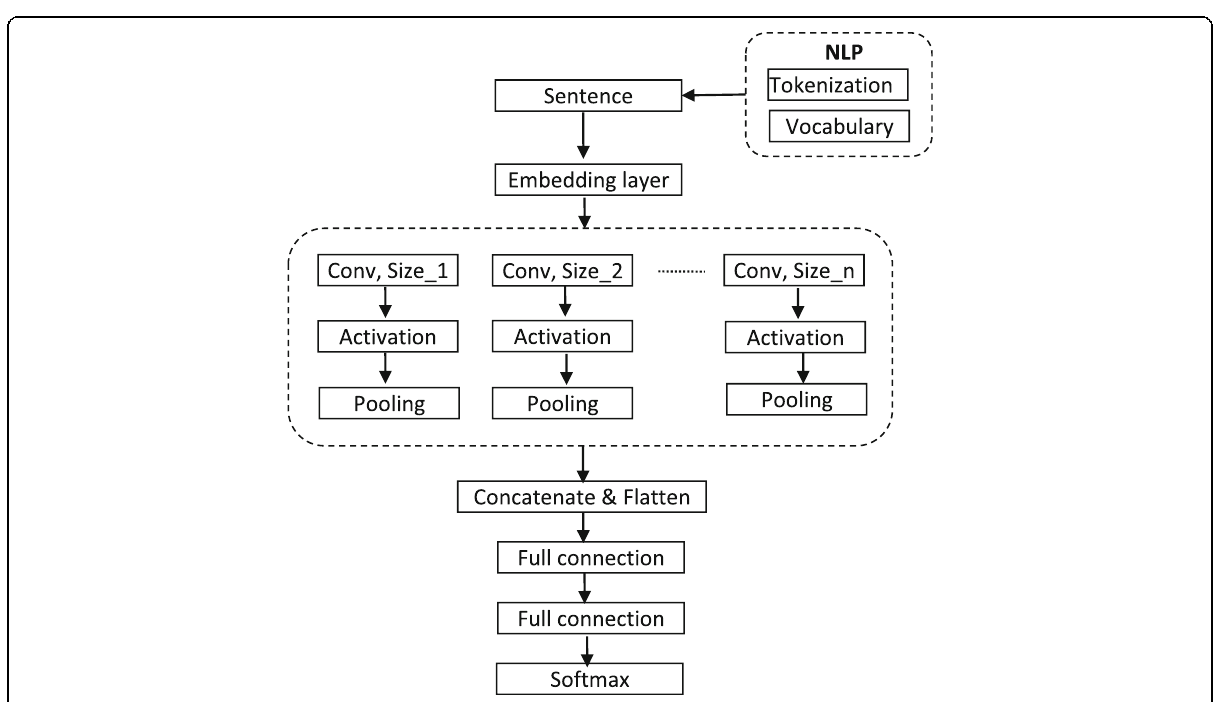
Fig. 3 Text classification model with convolution neural network net. Conv, Convolution; NLP, Natural language